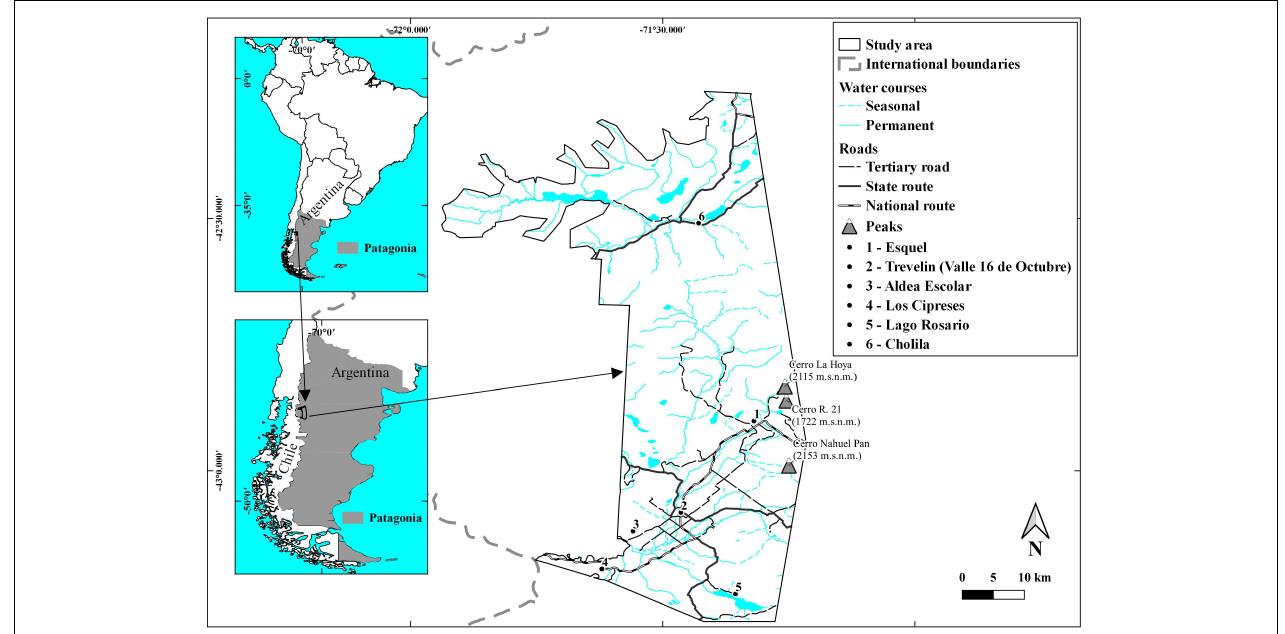
FIGURE 1 | Study area. It is located in south-western Argentina, in the Patagonian region.